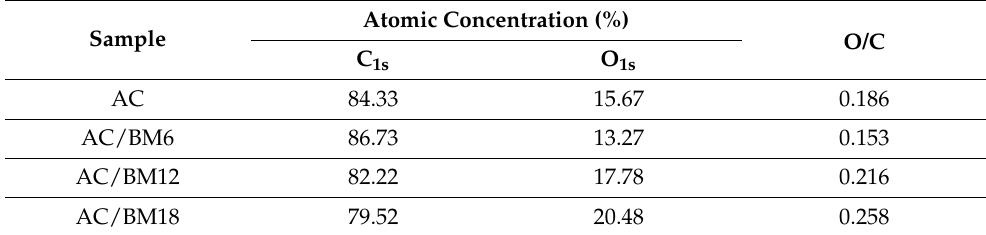
Table 2. Elemental composition of AC, AC/BM6, AC/BM12 and AC/BM18 samples.